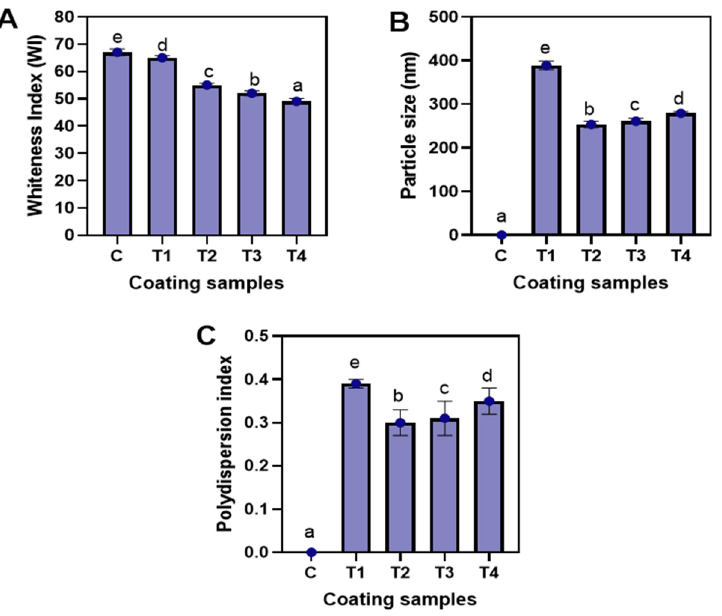
Figure 3. Whiteness index ( A ), particle size ( B ), polydispersity index ( C ) of the alginate coating and alginate-based nanoparticle coating with different concentration of LPE. C: distilled water; T1: alginate coating; T2, T3, and T4: alginate-based nanoparticle coating with 0.5, 1.0, and 1.5% LPE, respectively. The different alphabets shown on the bar diagram indicates significant